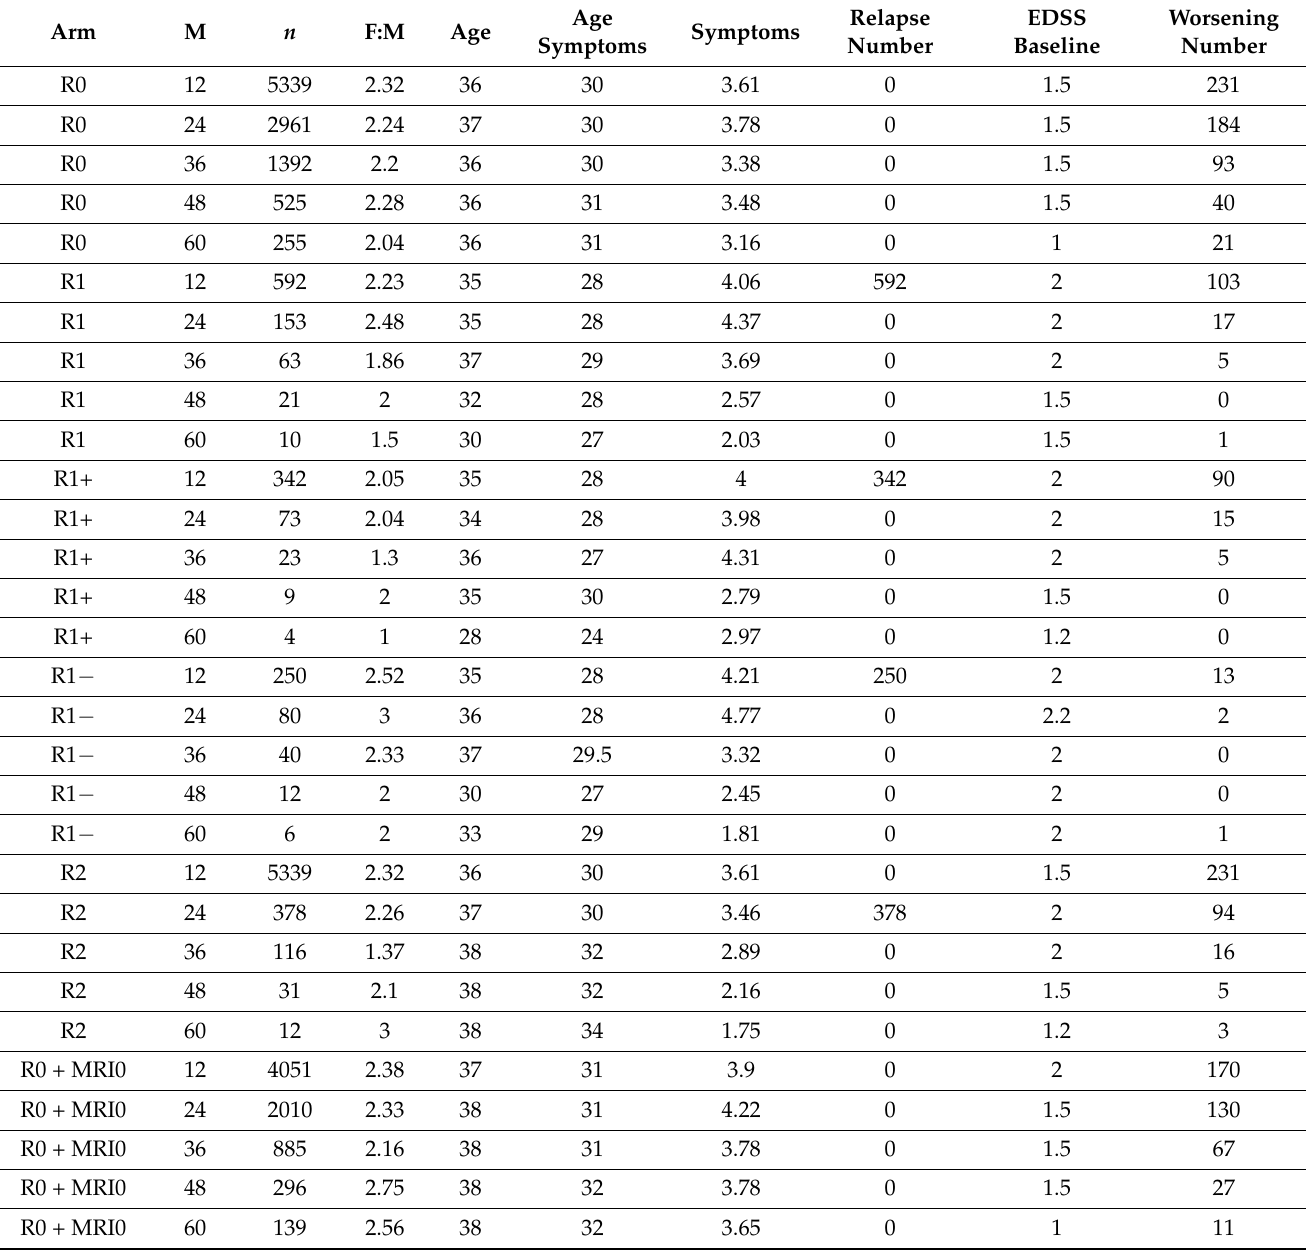
Table 1. Patient